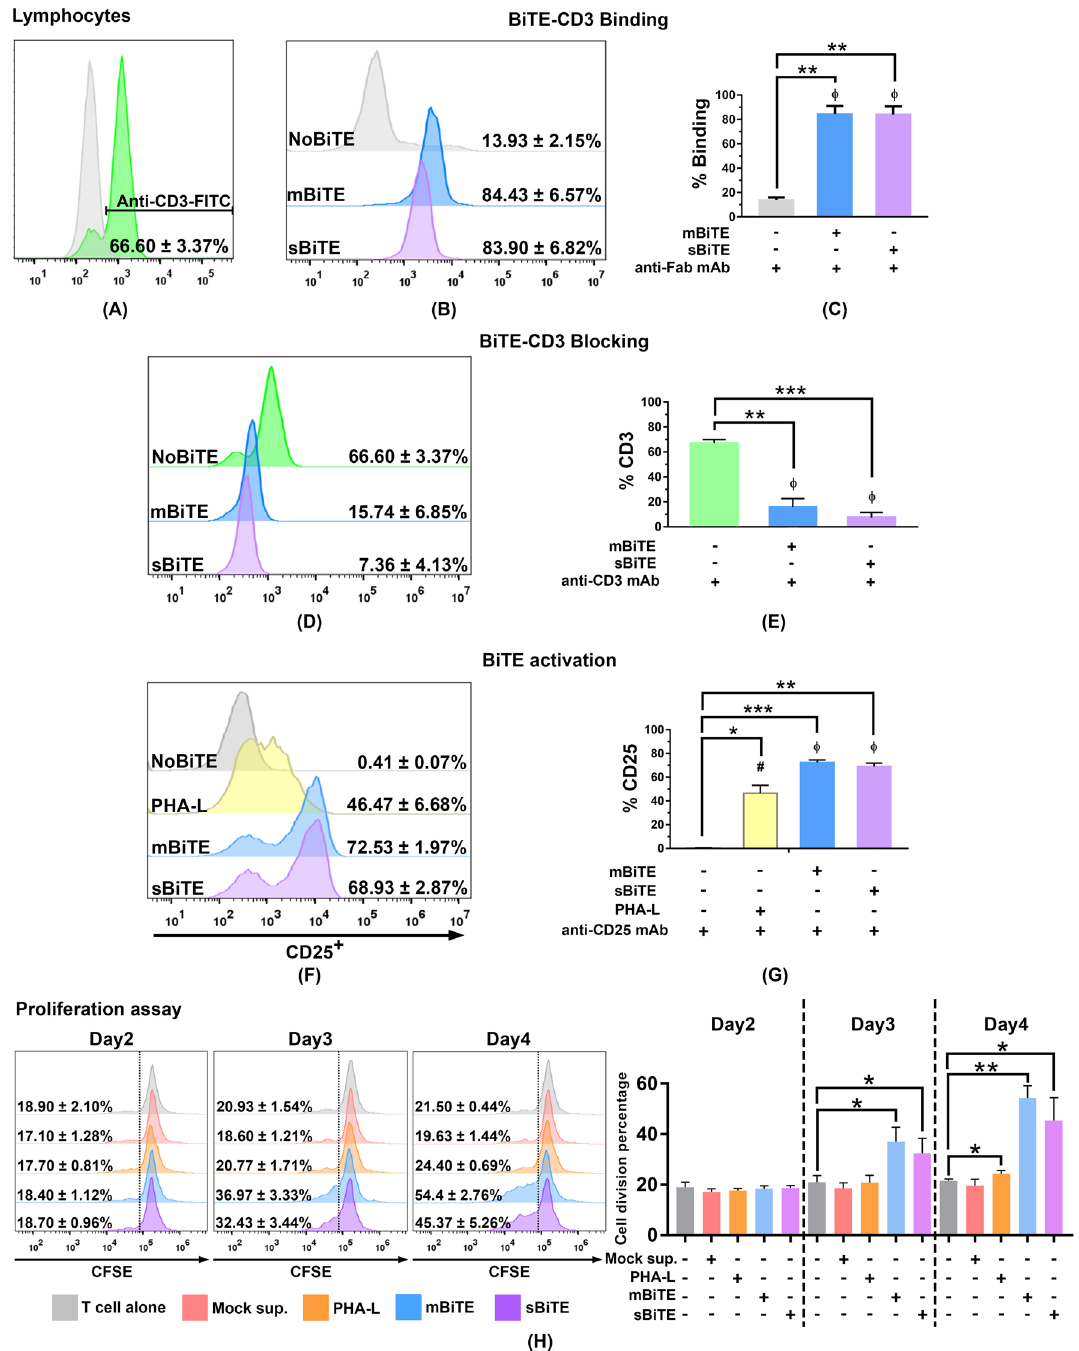
Figure 4. PD-L1xCD3 BiTE interacted to CD3 and activated T cells ( A ) CD3 positive lymphocyte population demonstrated as histogram. ( B and C ) The histogram showed the ability of mBiTE and sBiTE to directly bind to CD3 on T cells. The bar graph represents the % positive cells detected by anti-Fab mAb. ( D and E ) The histogram and bar graph showed % positive cells detected by anti-CD3 mAb after blocking with mBiTE and sBiTE (% blocking). ( F and G ) The histogram and bar graph showed % CD25 positive cells after 48 h of mBiTE and sBiTE treatment. ( H ) The histogram and bar graph demonstrated the activity of mBiTE and sBiTE to promote T cell proliferation after Day2-Day4 after treatment accessed by CFSE proliferation assay. Data are presented as the mean ± standard error or the mean (SEM) (* p < 0.05, ** p < 0.01, *** p <